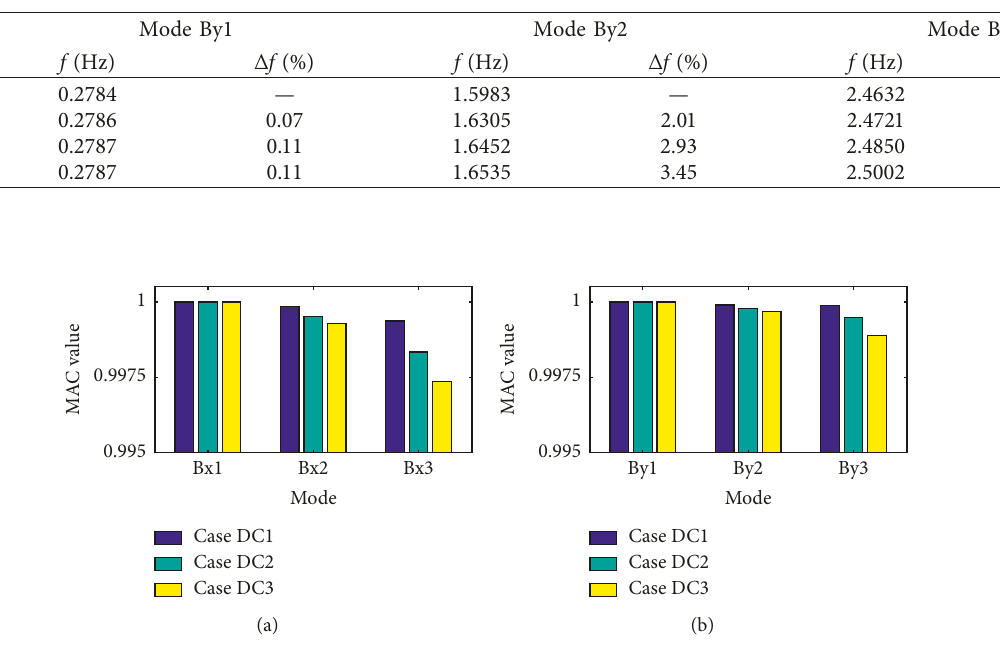
Figure 18: Modal assurance criterion (MAC) of mode shapes: damage type 2. (a) Along-wave modes. (b) Across-wave